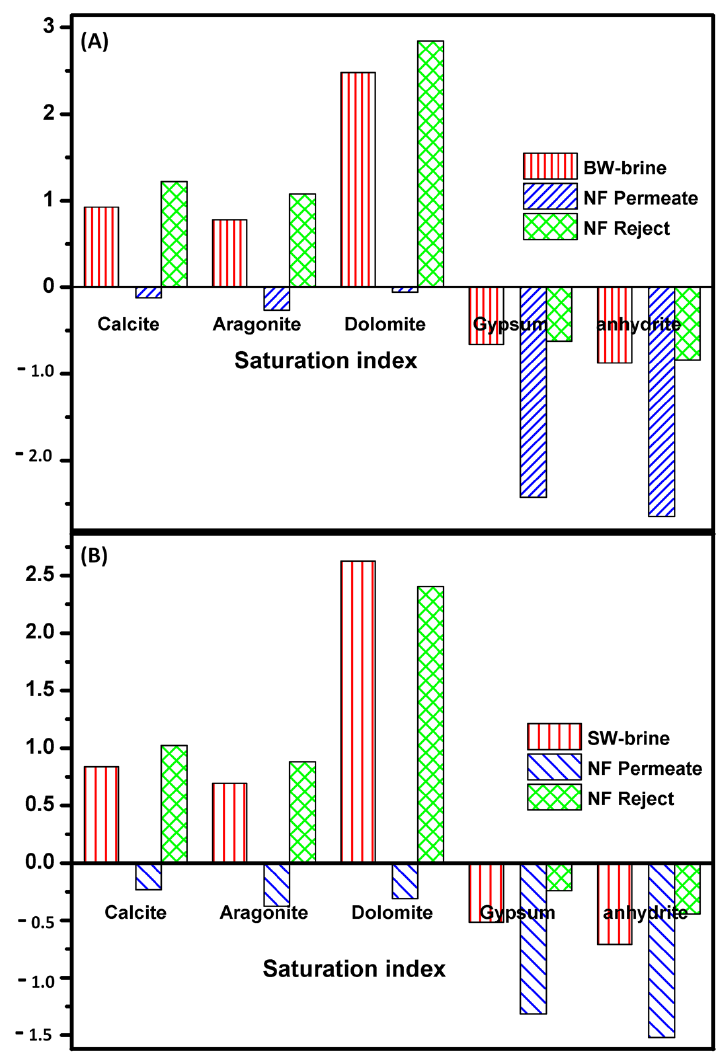
Figure 6. Saturation indices of RO-brine, NF permeate and NF brine of ( A ) BW and ( B ) SW samples operating conditions: pressure 0.7 MPa, operation time 8 h, operation temperature, 25 °C & flow rate, 5 L/min.